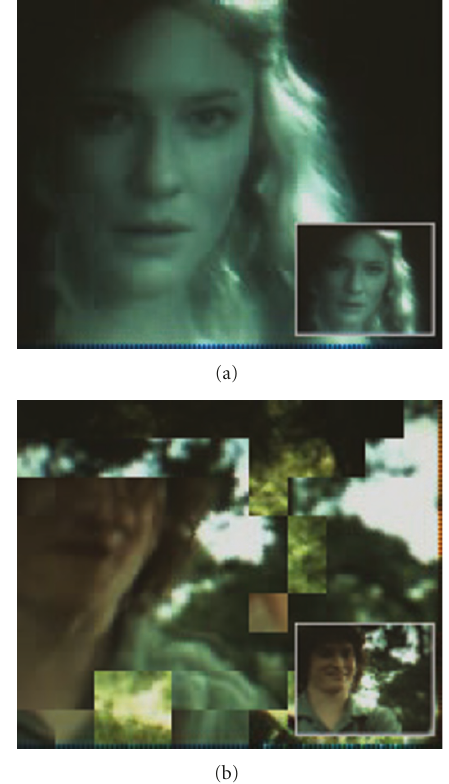
Figure 24: Screenshot of the videocall with a scenario of one hop (b) and ten hops